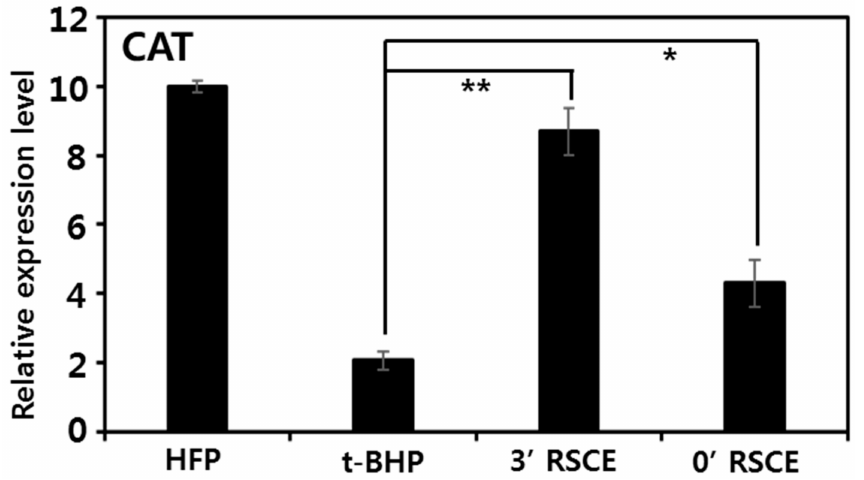
Figure 6. Antioxidant enzymes expression of RSCE. All measurements were made in 3 or more than 3 replicates. * p < 0.05; ** p <